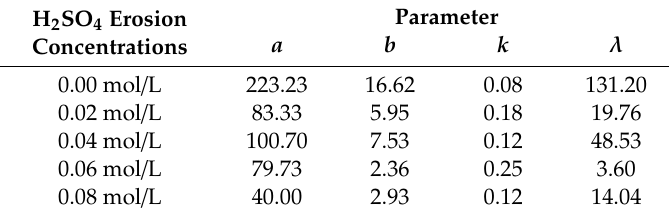
Figure 10. Comparison of stress–strain curves of di ff erent H 2 SO 4 erosion concentrations with REP model fittings. Table 1. Four parameter values of REP model under di ff erent erosion